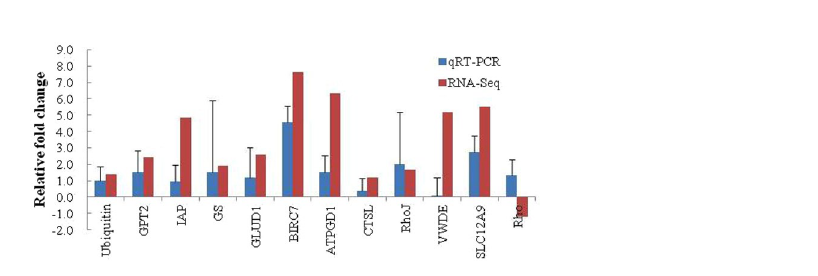
Figure 7. Validation of RNA-Seq results using RT–qPCR. The transcript expression levels of the selected genes were normalized to that of the β -actin